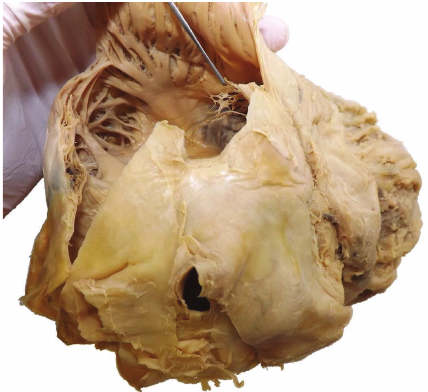
Figure 2: Opened right atrium of the heart and an overview of the Chiari network.